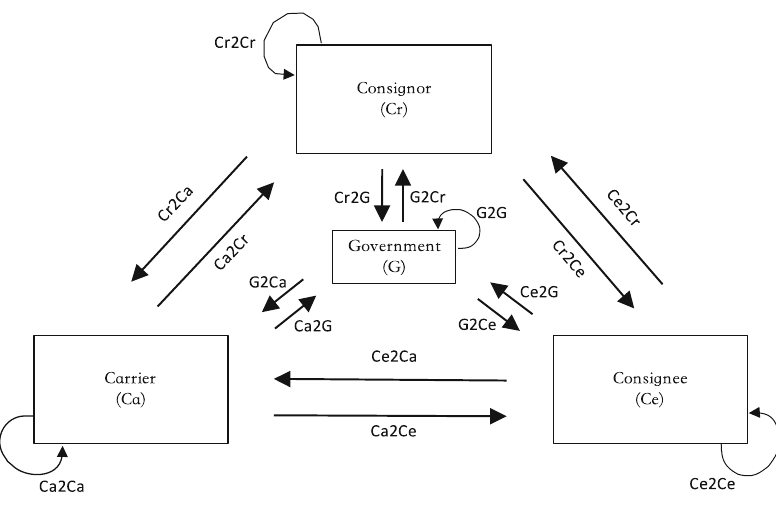
Fig. 3 Stakeholders in the freight movement